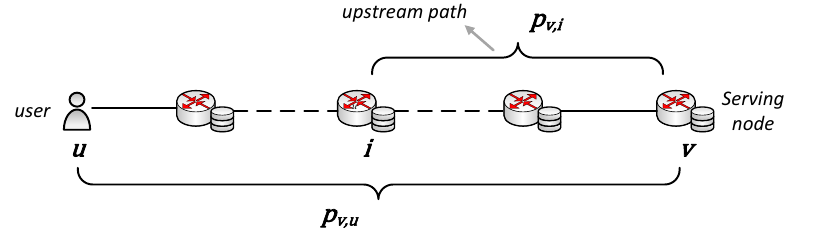
Figure 4. The illustration of upstream path.